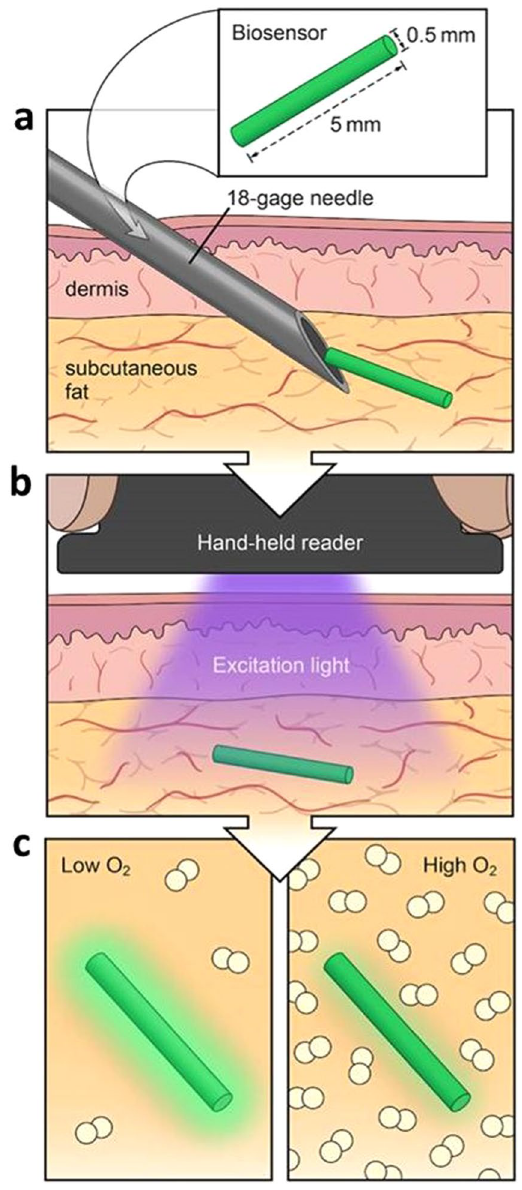
Figure 1. Injectable phosphorescence biosensor overview. ( a ) Small size (5 mm × 0.5 mm) allows local tissue measurements and injection by an 18 gauge needle. ( b ) Excitation light from reader reaches biosensor. ( c ) Sensor phosphorescence changes depending on oxygen concentration. Illustrated by Lauren Halligan, MSMI; copyright Duke University; with permission under a CC-BY 4.0